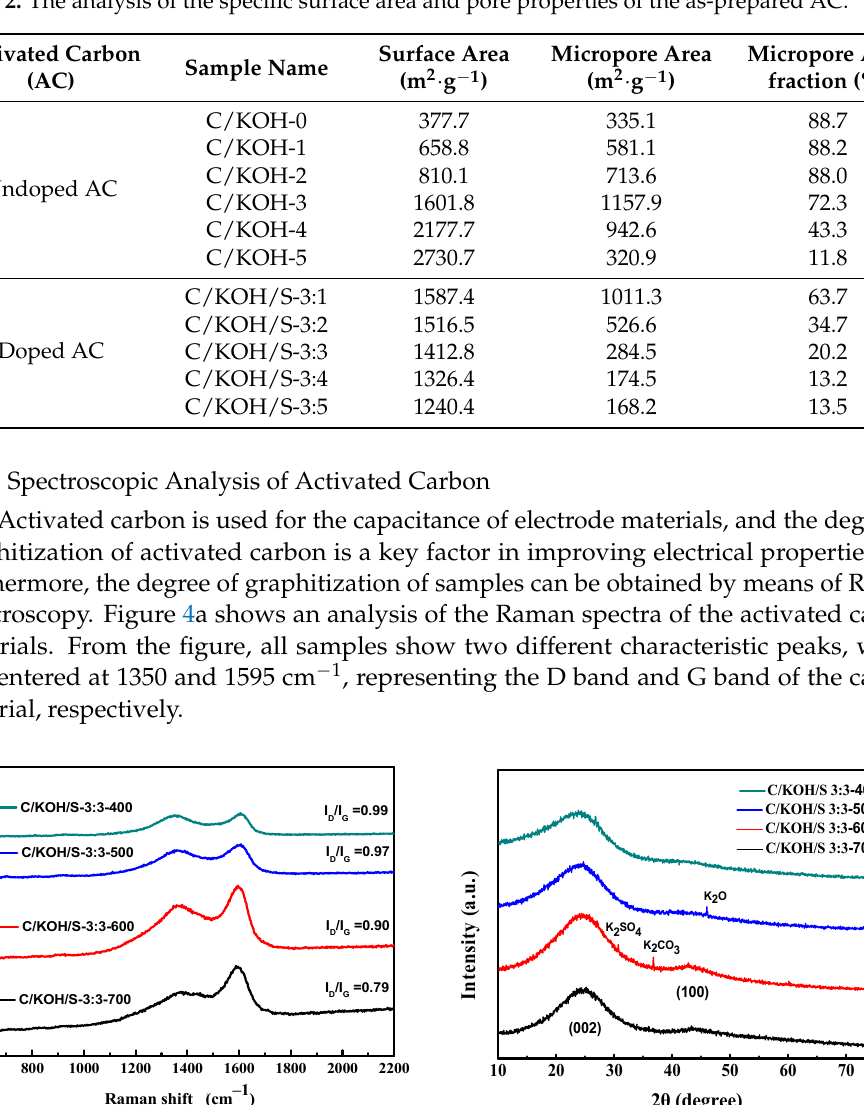
Table 2. The analysis of the specific surface area and pore properties of the as-prepared AC.